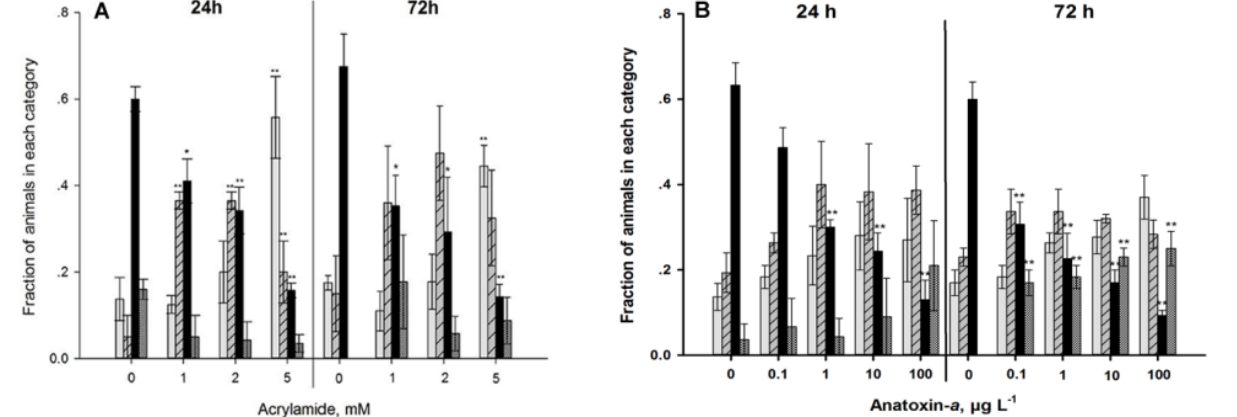
Figure 8. Thermotaxis of young adult nematodes after exposure for 24 h and 72 h. ( A ) exposure to acrylamide and a Microcystis culture filtrate. ( B ): exposure to anatoxin-a. ( C ): exposure to microcystin-LR. ( D ) exposure to a Microcystis culture filtrate. * = p < 0.05, ** = p < 0.01. ( grey : 17 °C, hatched : 17/20 °C, black: 20 °C, dark grey: 20/25 °C, white: 25